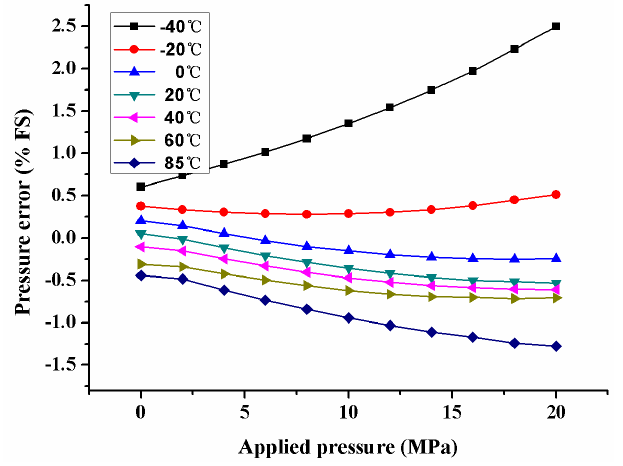
Figure 8. Pressure error in percentage between linear fit and actual